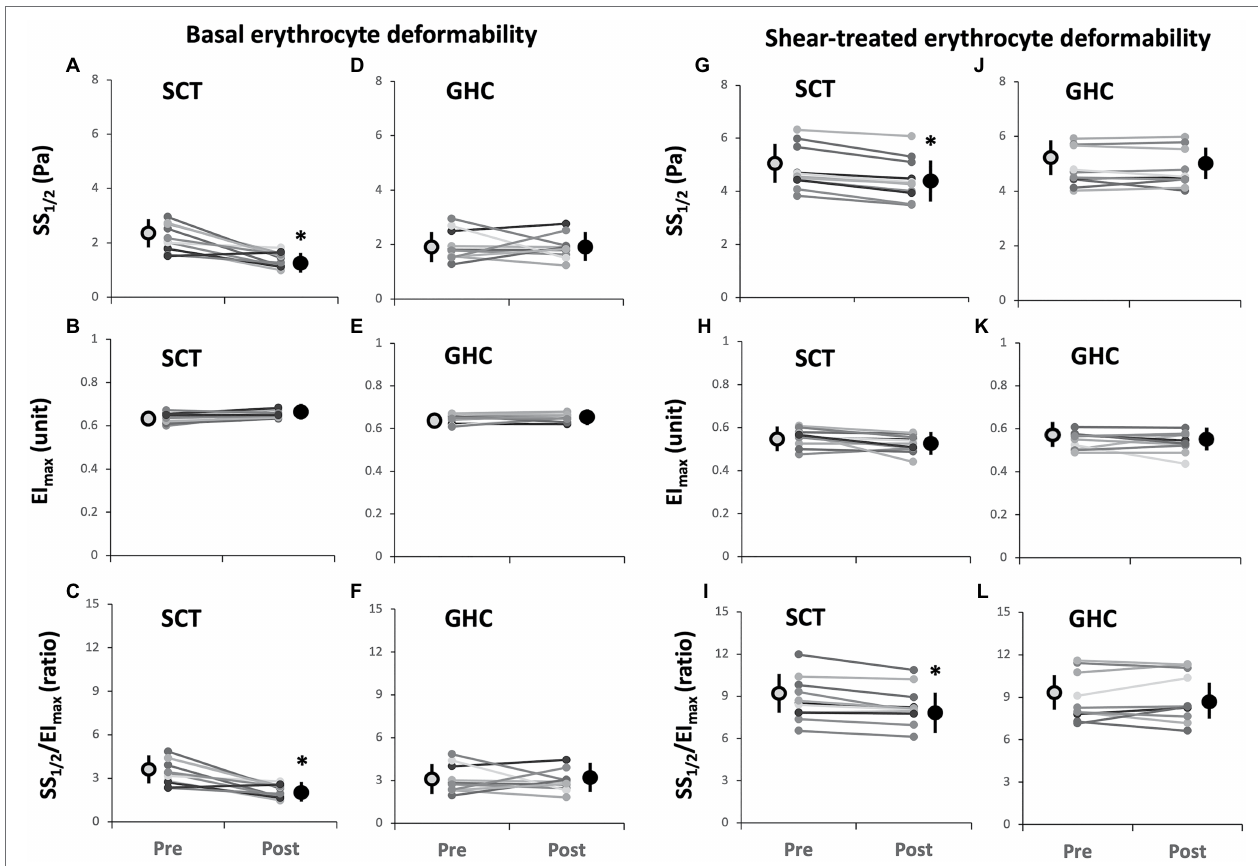
FIGURE 3 | Effect of SCT and GHC on basal [ (A-F) ] and shear-treated [ (G-L) ] erythrocyte deformability in PAD. SS 1/2 , shear stress at 50% maximal elongation defined as semi-maximal shear stress; EI max , maximal deformability; and SS 1/2 /EI max , ratio of SS 1/2 to EI max . Pre, pre-intervention; Post, post-intervention. Values are mean ± SD. * p < 0.05, pre or